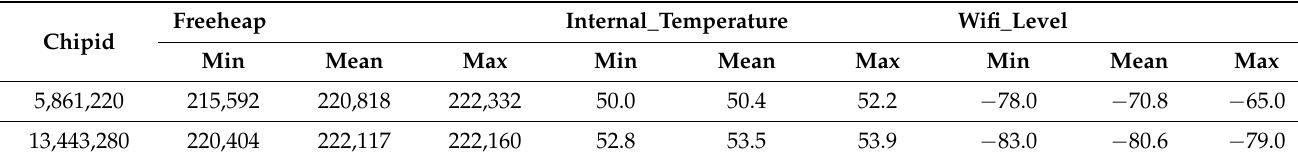
Table 2. Remote lab ESP32 metrics